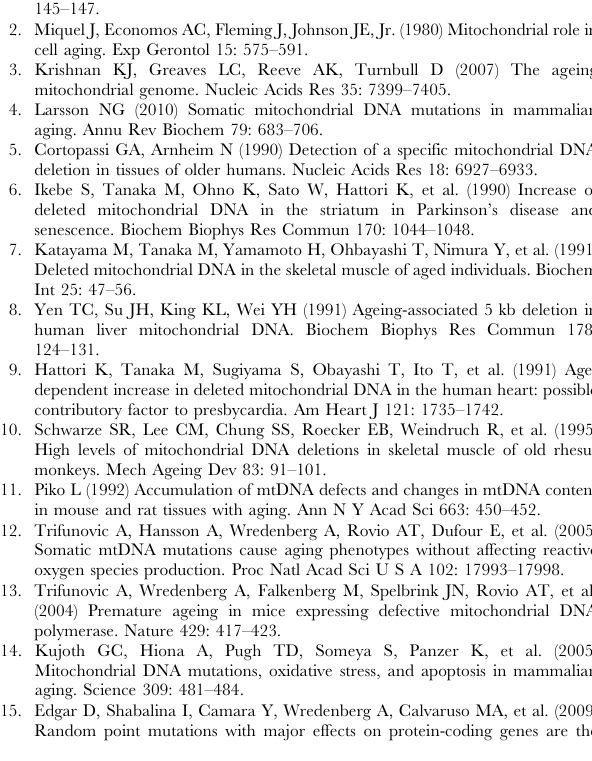
Table S6 Comparison of obtained mutation loads to literature values. Values reported as the per-site mutation 6 10 2 4